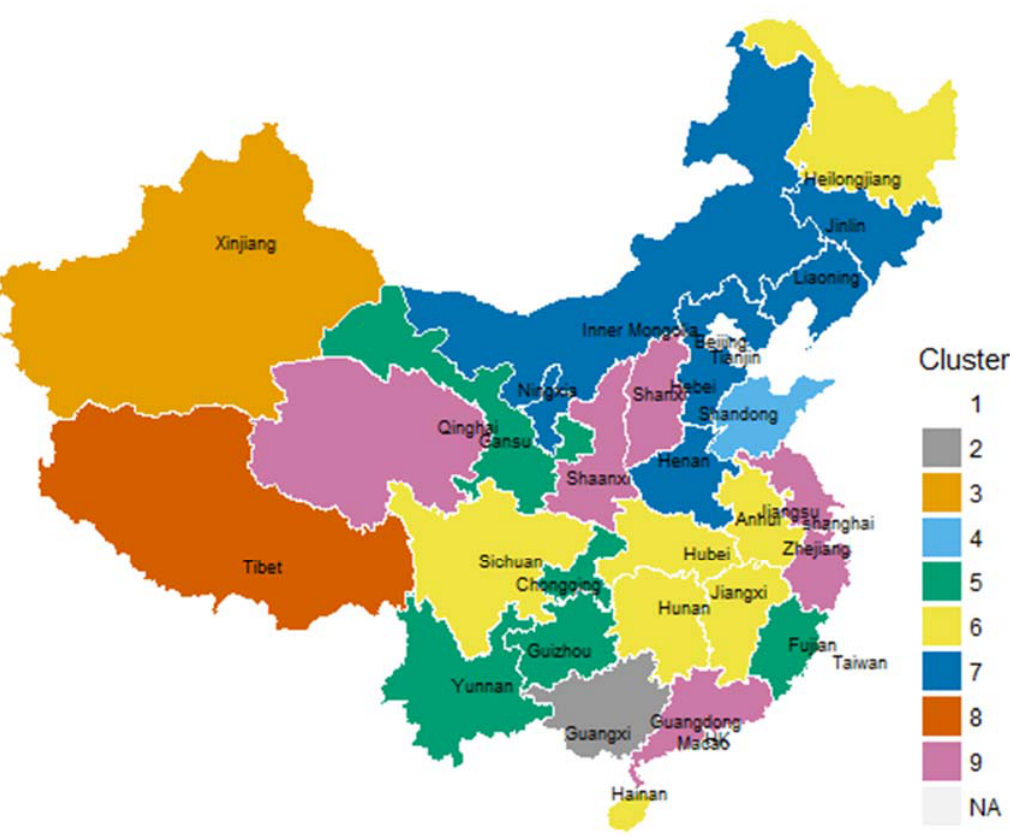
Figure 7. The spatial distribution of the clustering result.